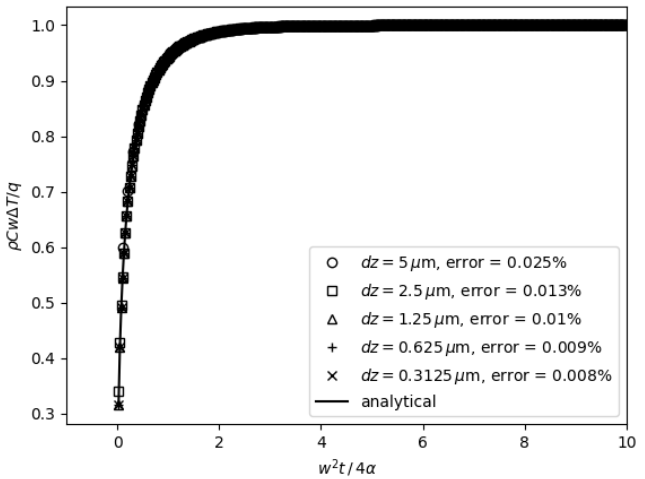
Figure 4. Comparison of temperature rise predictions using chtMultiRegionFoam and theory for one-dimensional conduction against convection, for a variety of different mesh sizes, holding the Fourier number